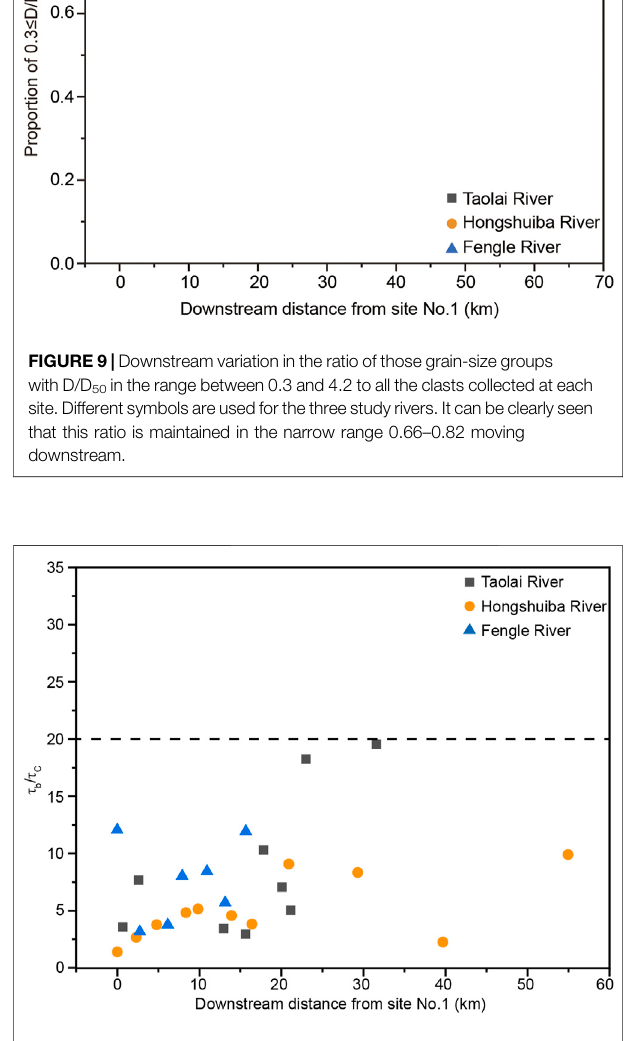
FIGURE 10 | Downstream variation in the ratio of τ b to τ c at each sampling site. All the ratios obtained are < 20.